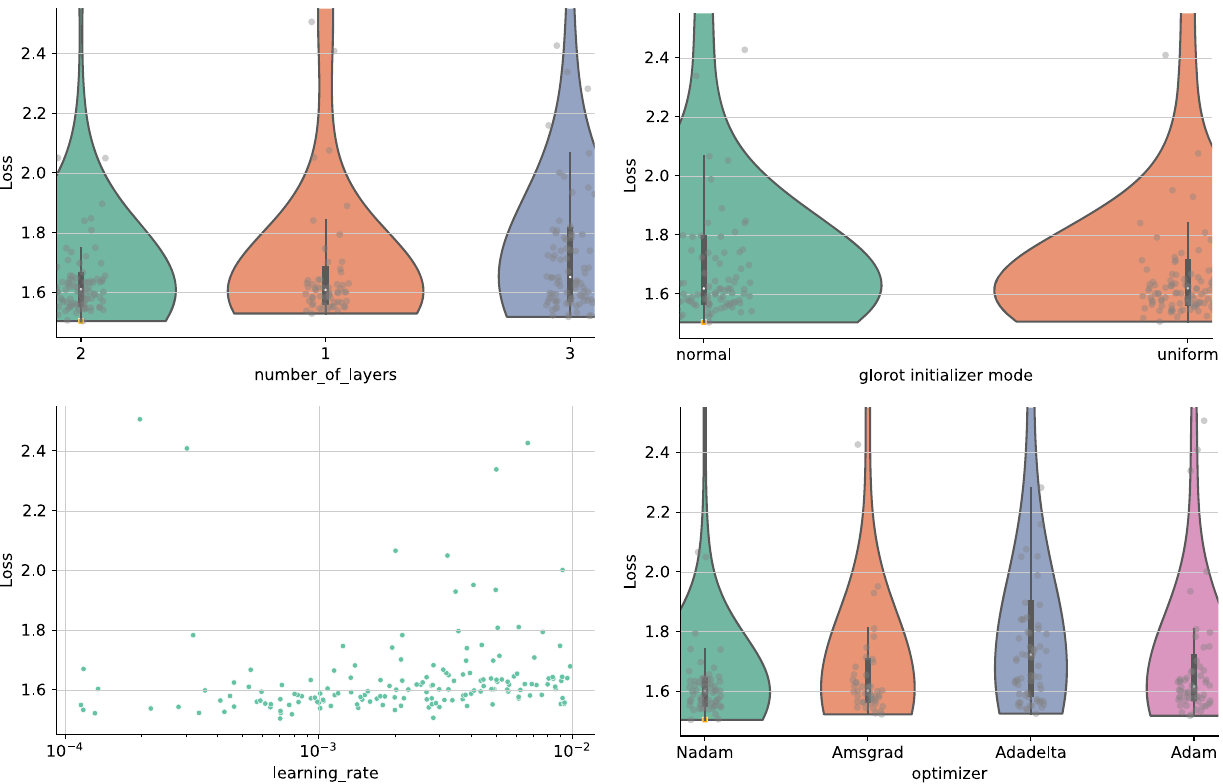
Fig. 6 Graphical representation of the hyperoptimization loss function L corresponding to a subset of the hyperparameters in a scan based on 1500 configurations